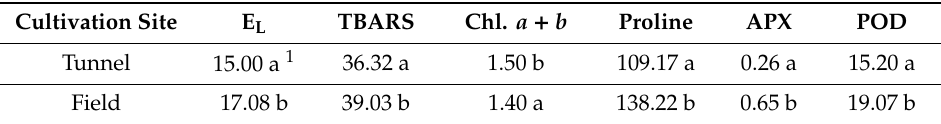
Figure 2. E ff ect of growth conditions (unheated foil tunnel and open field) and foliar treatment (six times during vegetative period) with di ff erent concentrations of Pentakeep V (0.00%, 0.02%, 0.04%, 0.06%) on the content of thiobarbituric acid reactive substances (TBARS) in leaves measured after 1, 17, and 30 days of storage of the P. multiflorum cut foliage in water. Values are mean ± SE, n = 5. The bars marked with the same letters are not significantly di ff erent at p < 0.05. Table 2. E ff ect of growth conditions (unheated foil tunnel and open field) on the mean values (comparative from days 1, 17, and 30) of parameters (electrolyte leakage, thiobarbituric acid reactive substances, chlorophyll a + b , proline, ascorbate peroxidase, guaiacol peroxidase) in P. multiflorum leaves. The averages in the table result from a three-factor statistical analysis.